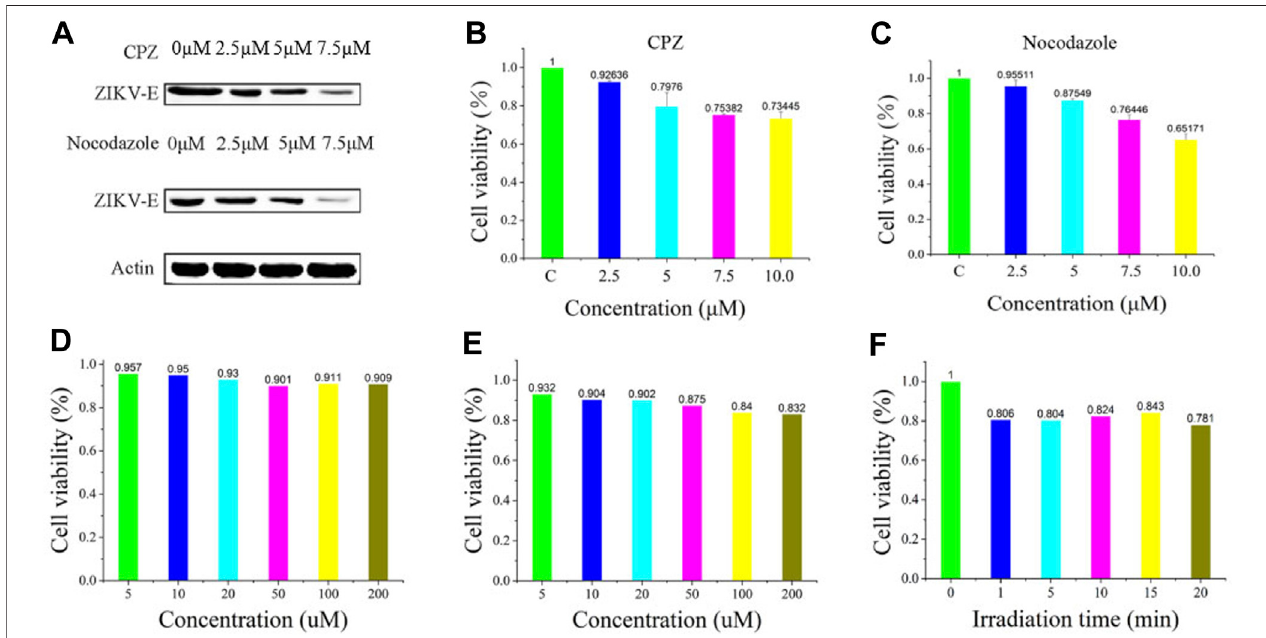
FIGURE 4 | (A) Levels of β -actin and ZIKV envelope protein E (ZIKV E) of SNB19 cells treated with CPZ or nocodazole. Cytotoxicity studies of (B) CPZ and (C) nocodazole. Cytotoxicity studies of (D) PQ and (E) VE, or (F) irradiation time.